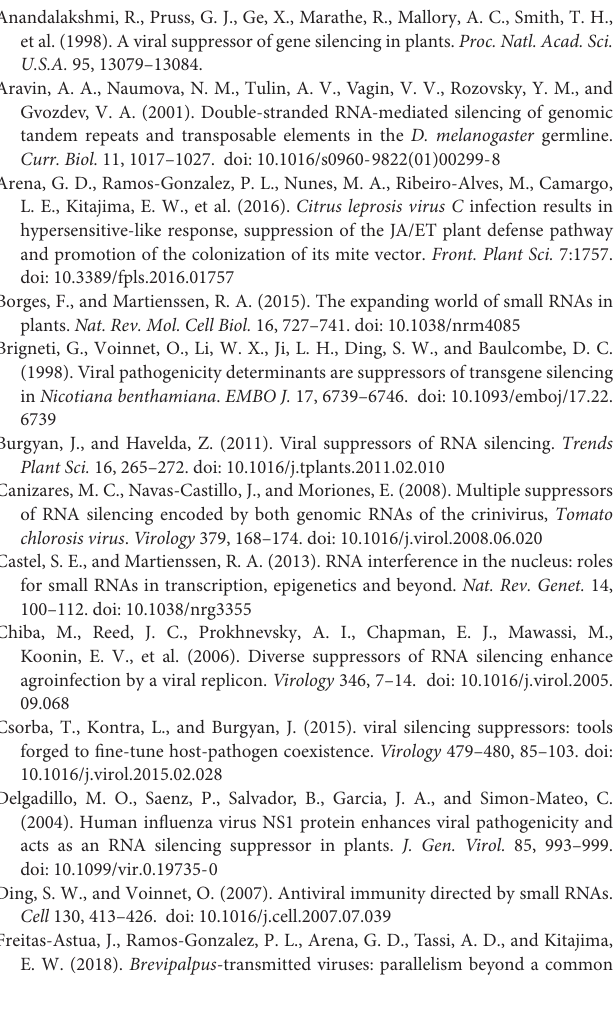
vectororconvergentevolutionofdistantlyrelatedpathogens? Curr.Opin.Virol. 33, 66–73. doi: